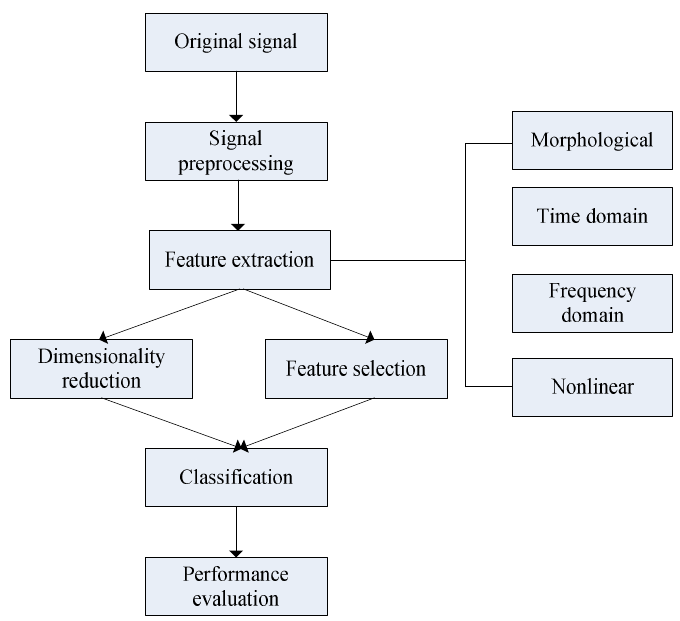
Figure 1. A schematic presentation of our proposed approach.